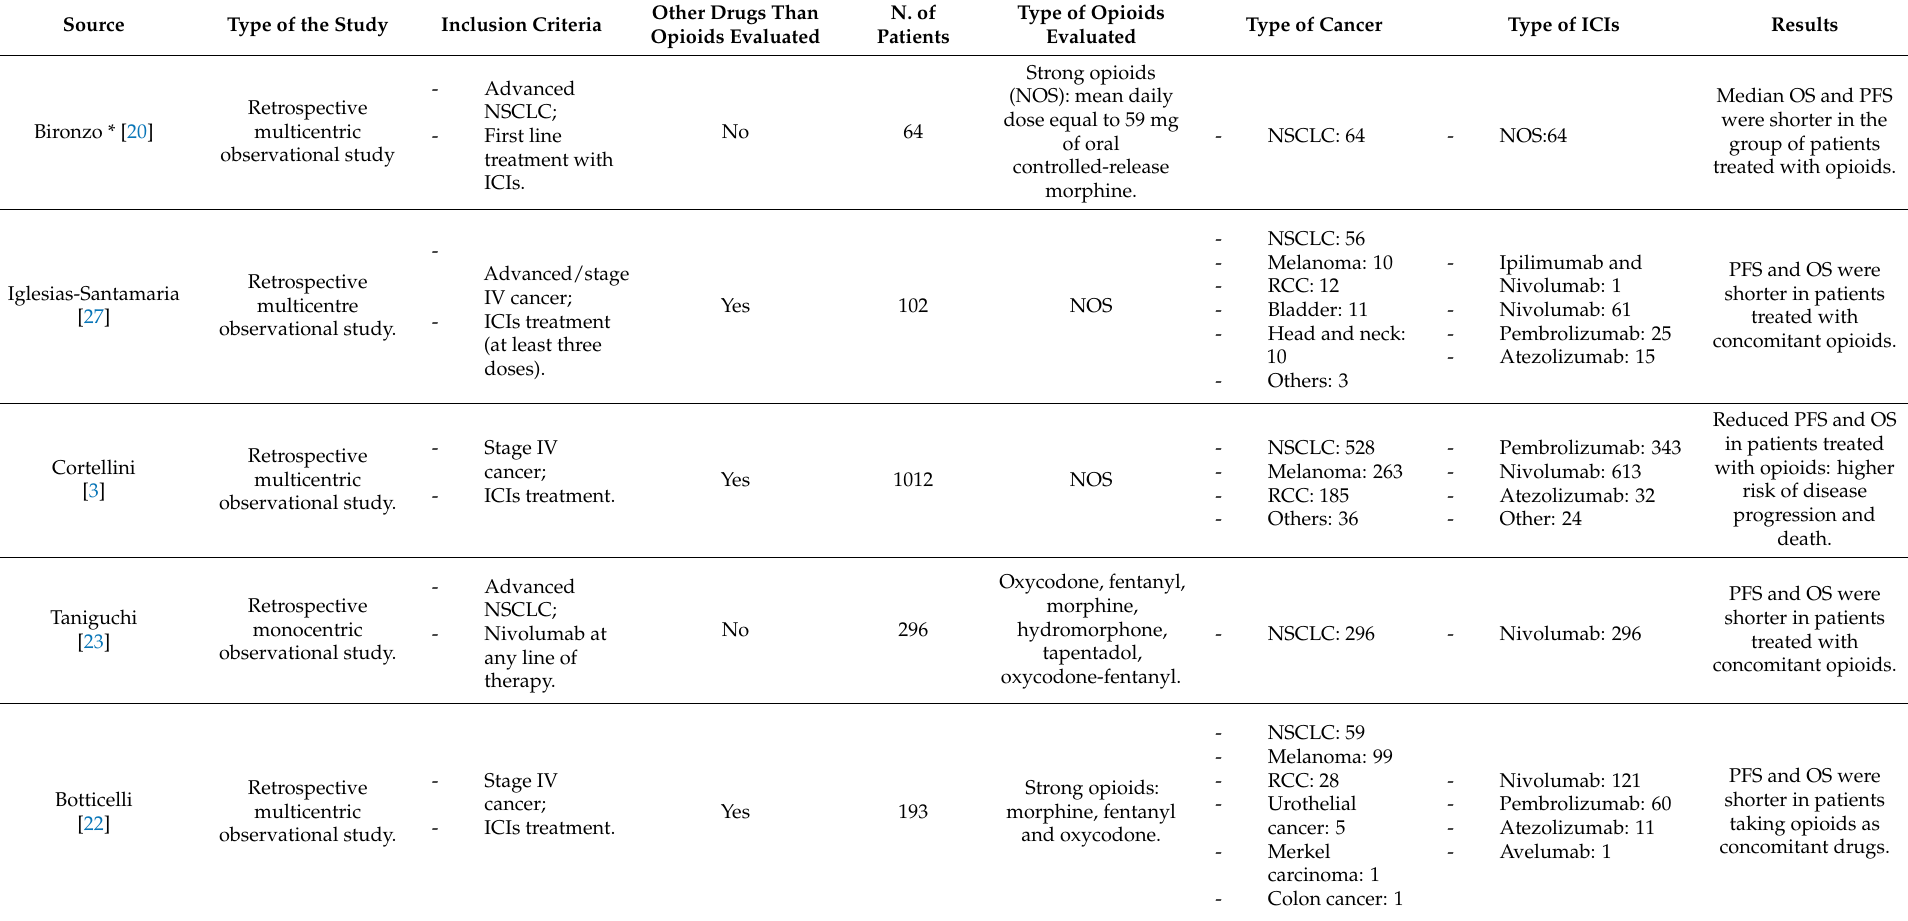
Table 1. Characteristics of the selected